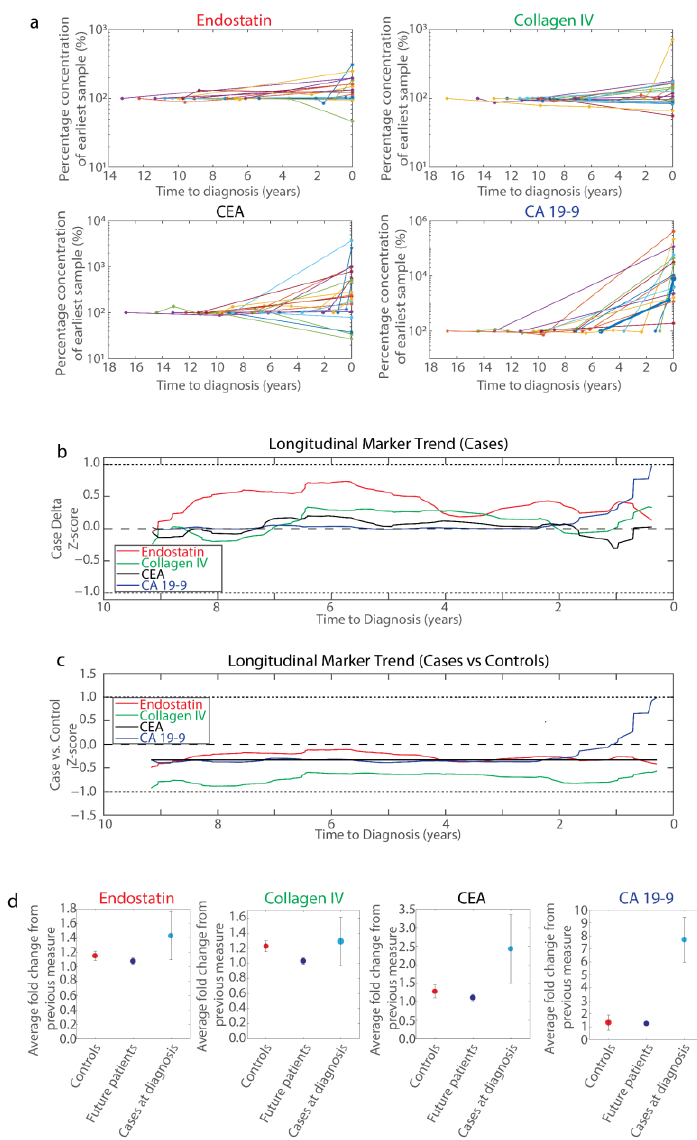
Figure 4. Longitudinal examination of blood plasma biomarker fluctuations. ( a ) Spaghetti plots of blood plasma biomarker concentrations (top left, Endostatin ( n = 18); top right, Collagen IV ( n = 20); bottom left, CA19-9 ( n = 16); bottom right, CEA ( n = 20)) normalized to the first pre-diagnostic sample per patient (%) against time to diagnosis (years) for patients that provided both samples at diagnosis and pre-diagnostic samples (that is, those patients that provided samples at diagnosis in Figure 1b). Different colored lines represent different patients. In the CA19-9 panel, one patient demonstrated elevated circulating CA19-9 levels prior to diagnosis, but no elevated levels for the other markers (blue, bold). ( b ) Longitudinal changes in blood plasma biomarkers in future PDAC patients with respect to marker fluctuations of successive samples. Plotted for each marker are the mean change in marker expression for 89 chronologically successive batches of 20 future patient delta samples divided by the standard deviation of all future patient delta samples (Case delta Z-scores, y-axis) against the average time to diagnosis of the latest delta sample in each batch of 20 deltas (x-axis). Each line was generated by applying a Savitzky–Golay filter to these data points. Values greater than zero indicate that there was an increase in marker expression from the previous measure in future patients, and the converse for values less than zero. ( c ) Longitudinal changes in blood plasma biomarkers of future PDAC patients in context of marker fluctuations in healthy subjects. Points were plotted similarly as in ( b ), except that the mean delta for all control subjects was subtracted from each